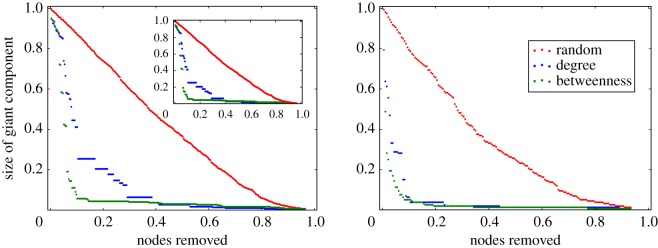
The relative sizes of the giant components as a function of the percentage of nodes removed. In the left panel the size of the giant component for the unsigned network is given. That of the positive network, which has a very similar decay, is given as an insert. The right panel shows the decay of the giant component of the negative network as nodes are removed. The red data points correspond to random removal of nodes and the blue and green data concern removal by highest degree and betweenness, respectively.